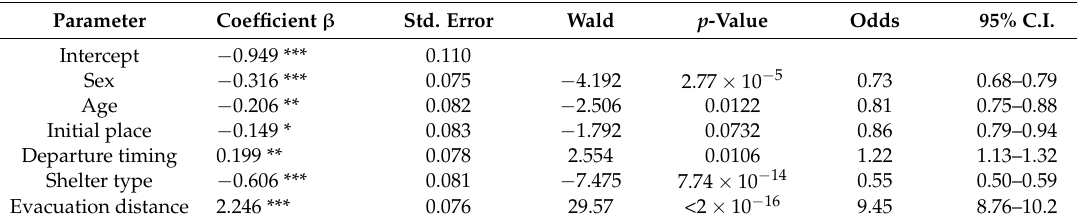
Table 1. Model estimation results.